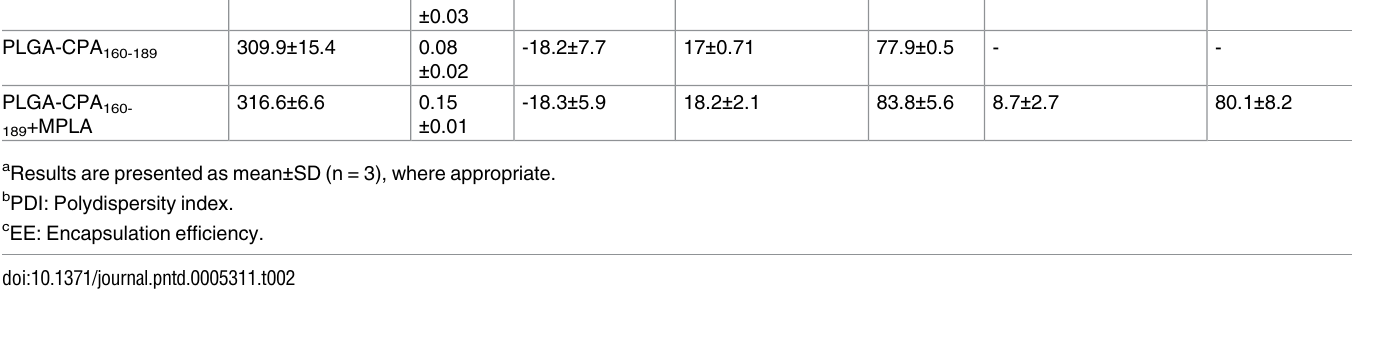
DCs stimulated with the above PLGA NPs induced the differentiation and proliferation of peptide-specific Th1 or Th2 cell populations, analysis of mRNA expression for IFN- γ , IL-4 and IL-10 cytokines that are indicative of the respective T cell populations, was conducted. According to the results, priming of naive splenocytes with DCs that have been pulsed with the PLGA-CPA +MPLA NPs stimulated significant upregulation of both IFN- γ and IL-10 tran- 160-89 scripts by 1.5-fold ( p < 0.05) over those spleen cell cultures treated with immature DCs, whereas